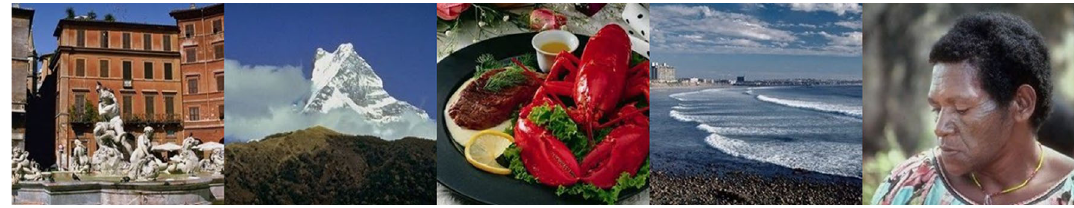
Fig. 17 Sample images of Corel 1000 image dataset